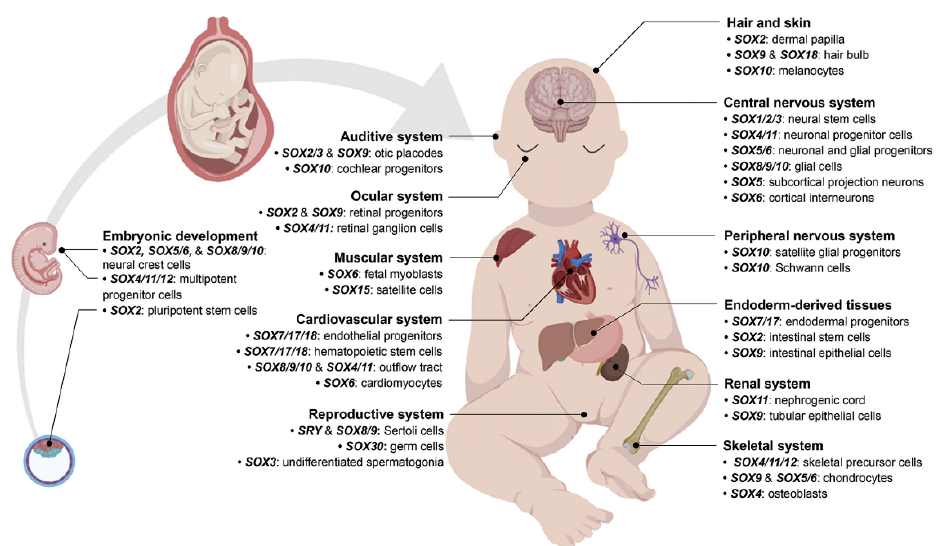
Figure 3. Developmental aspects of SOX protein subfamilies. SOX genes play crucial functions in hair, skin, eye, auditive system, musculoskeletal system, cardiovascular system, nervous system, gastrointestinal system, reproductive system, and embryonic development. Reprinted by permission from Elsevier, Trends in Genetics [49], Copyright 2019.